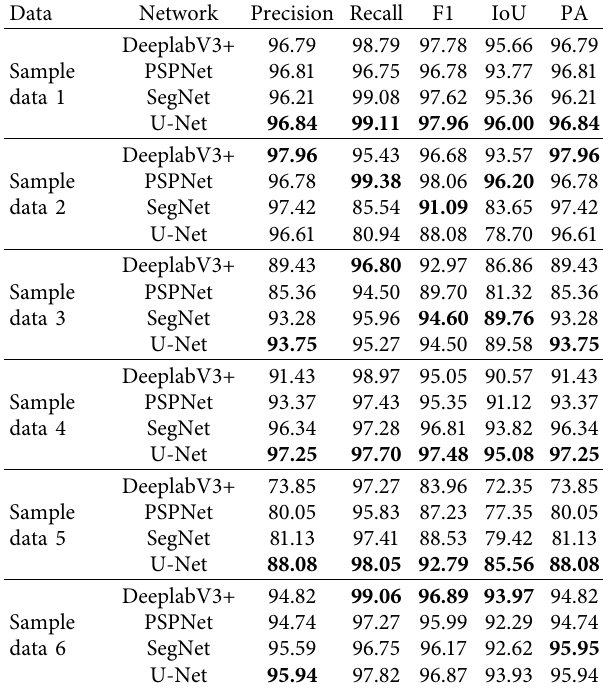
Figure 9: Semantic segmentation results of four kinds of networks: (a) sample data 4; (b) sample data 5; (c) sample data 6; (d) label data of sample data 4; (e) label data of sample data 5; (f) label data of sample data 6; (g) DeeplabV3+ result of sample data 4; (h) DeeplabV3+ result of sample data 5; (i) DeeplabV3+ result of sample data 6; (j) PSPNet result of sample data 4; (k) PSPNet result of sample data 5; (l) PSPNet result of sample data 6; (m) SegNet result of sample data 4; (n) SegNet result of sample data 5; (o) SegNet result of sample data 6; (p) U-Net result of sample data 4; (q) U-Net result of sample data 5; (r) U-Net result of sample data 6. Table 3: The accuracy evaluation indicators of 6 sample data.